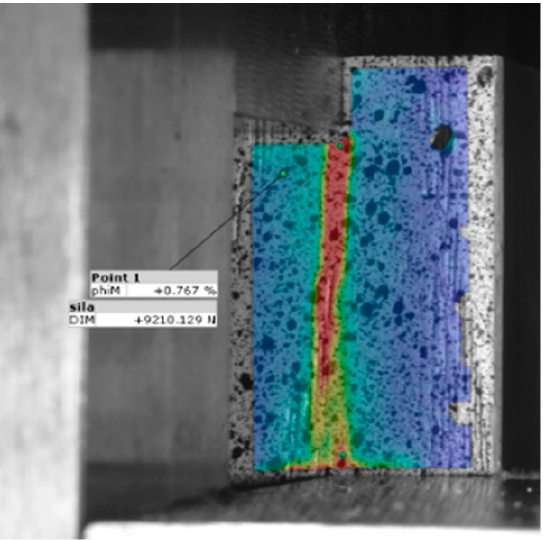
Figure 3. Side view of the specimen during a test with the randomly sprayed black specks pattern for digital image analysis and overlapping coloured strain distribution obtained by the software.